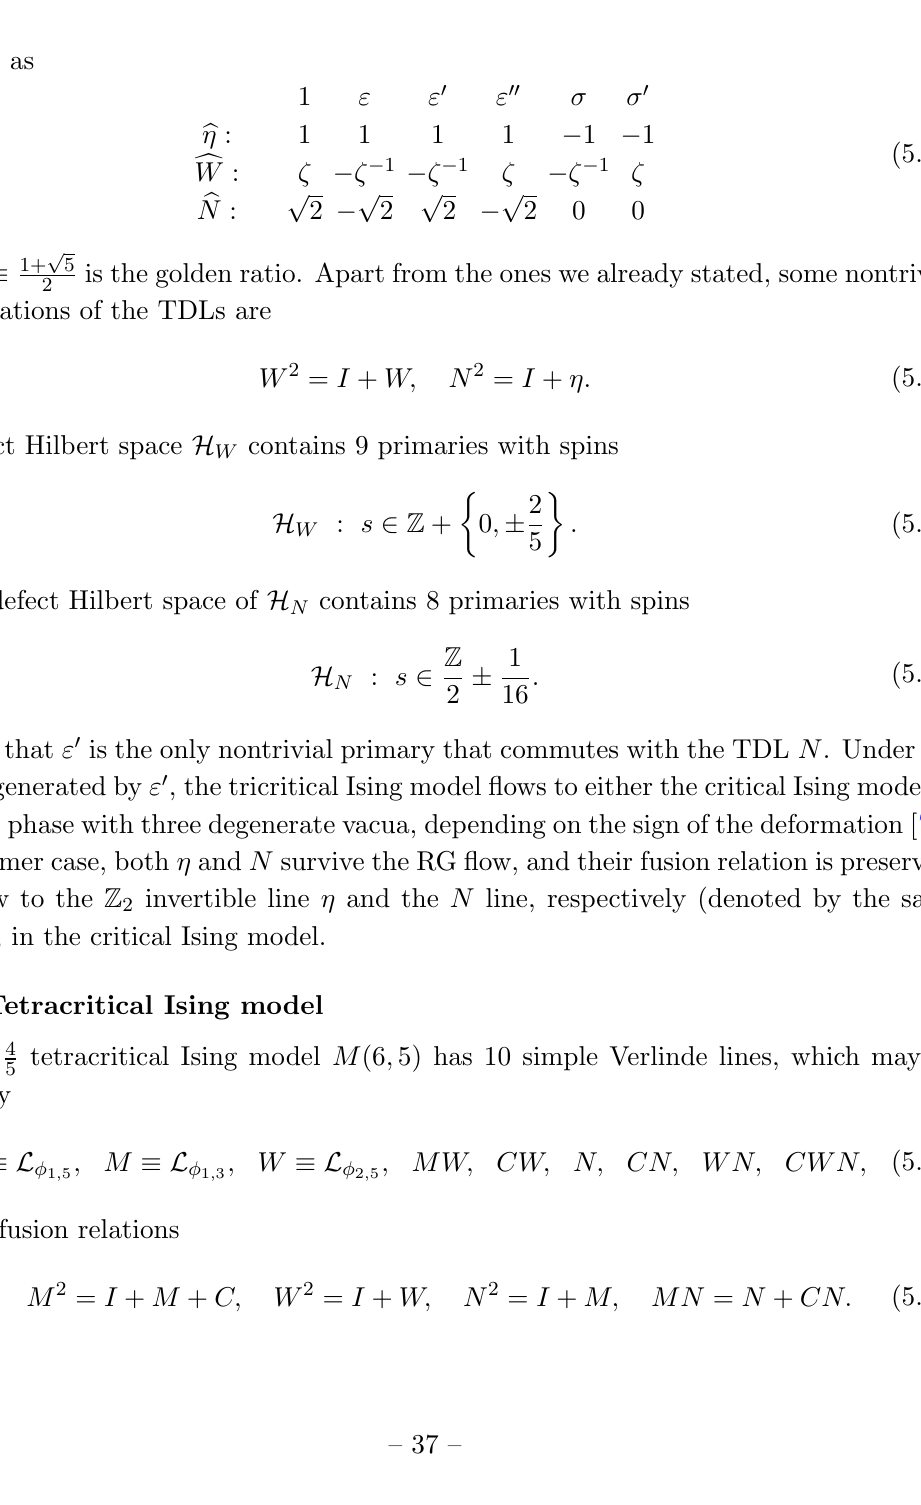
Figure 33 . The torus one-point function of attached to an N loop via the NN(cid:17) junction, h i and h i N T 2 ;N T 2